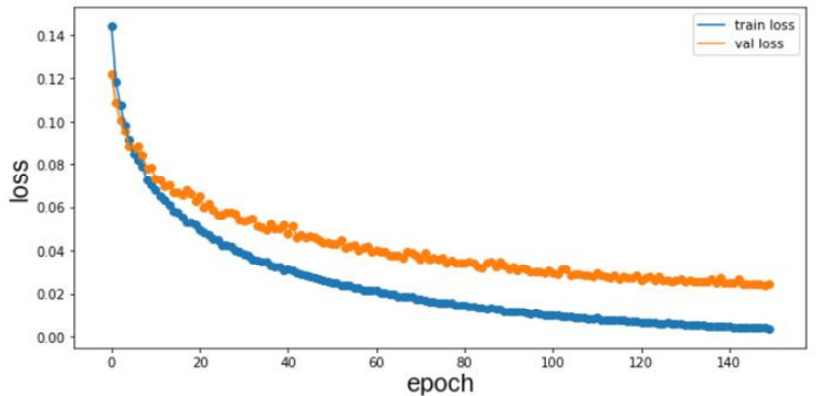
Figure 6. The relationship curve between loss and epoch.